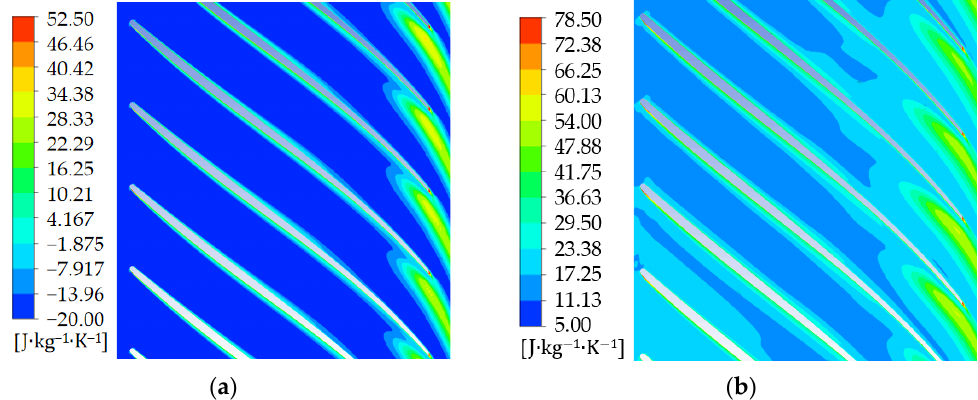
Figure 19. Static entropy contours of 50% heights of impellers. ( a ) First stage. ( b ) Second stage.